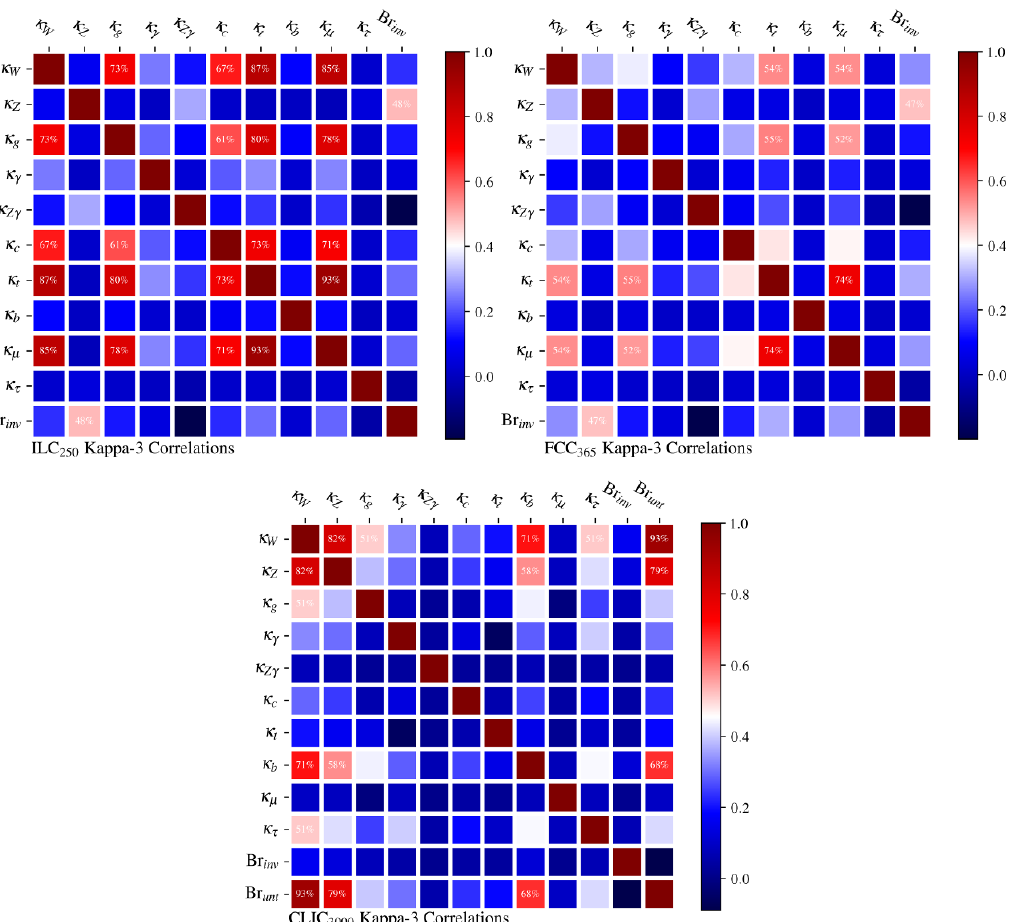
Figure 14 . Correlation seen in the kappa-3 scenario (cid:12)t for three future colliders as discussed in section 3.2. Top left: ILC 250 . Top right: FCC 365 . Bottom: CLIC 3000 .